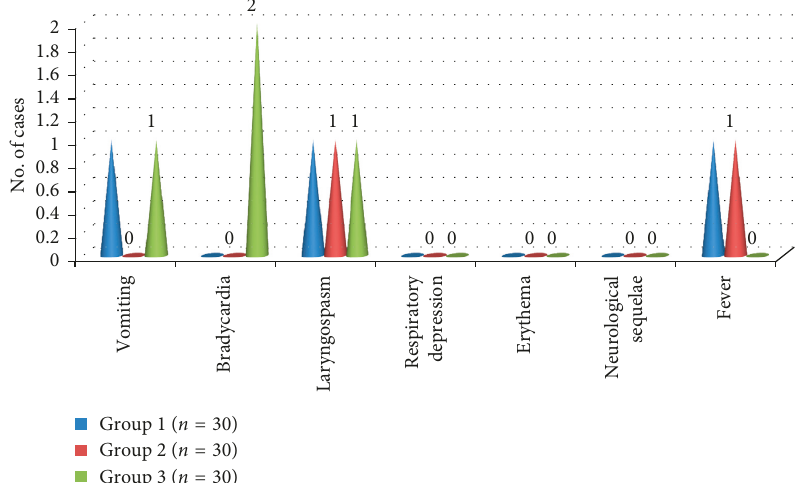
Figure 3: Various complications encountered in all the three groups: group 1 (levobupivacaine); group 2 (ropivacaine); group 3